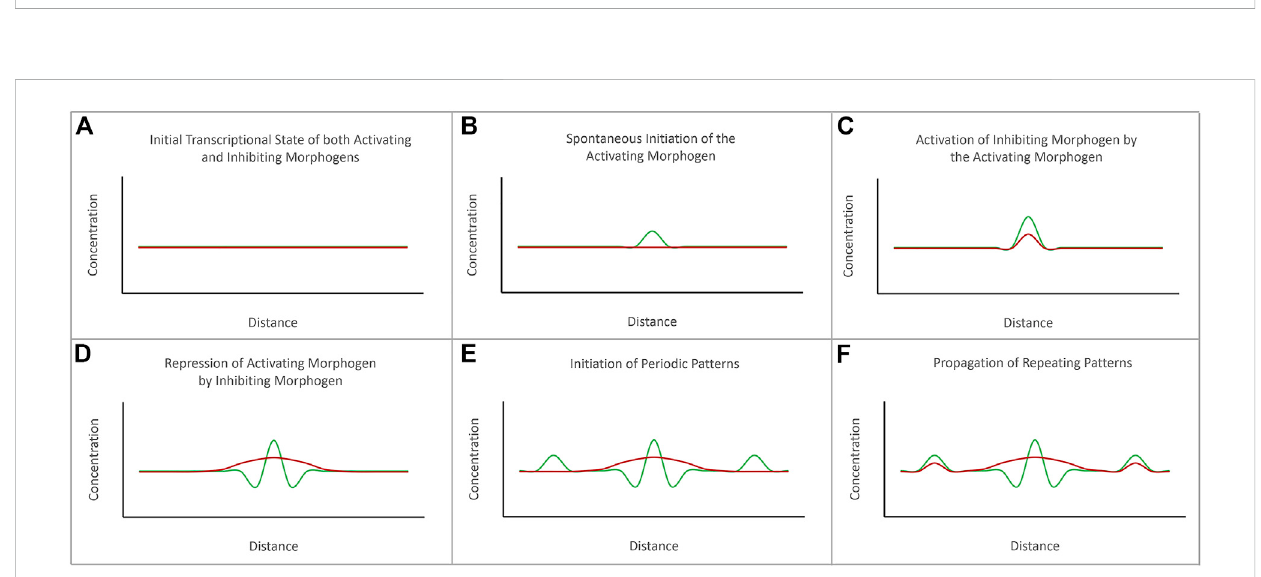
FIGURE 2 The diffusion-reaction model for the de novo initiation of repeated patterns. Alan Turing proposed that repeated patterns could spontaneously be generated via thecombinedactivitiesofactivatingandinhibitingmorphogens. (A) Priortotheinitiationofpatternformation,theexpressionlevelsofboth activating and inhibiting morphogens are at baseline levels. (B) The initiation of a pattern begins with the spontaneous initiation of expression of the activating morphogen. (C) As levels ofthe activating morphogen rises, it activates expressionof the inhibiting morphogen. (D) The expressionlevels of the activating morphogen are higher than the inhibiting morphogen at the source. However, the inhibiting morphogen can diffuse further than the activatingmorphogen. (E) Theinhibitingmorphogensuppressestheexpressionoftheactivatingmorphogenfurtherawayfromthesource.However,just beyond the range of the inhibiting morphogen is seen spontaneous activation of the activating morphogens. (F) The process repeats itself to generate a periodically spaced pattern of repeated elements. The schematic is adapted from Sharpe and Green,